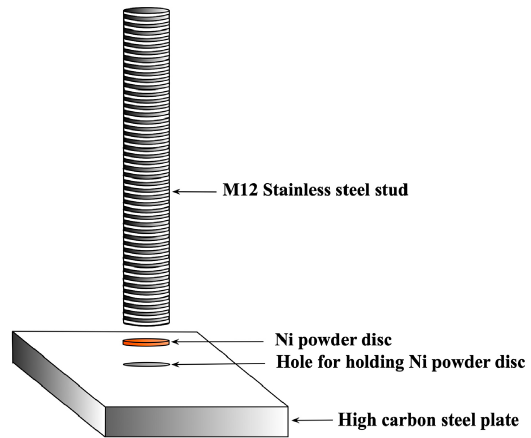
Figure 1. Schematic illustration of the ASW